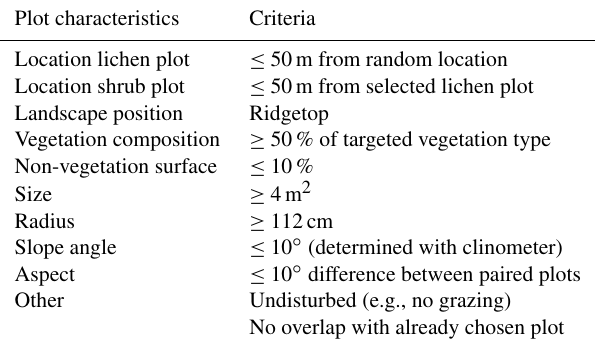
Table 1. Criteria for the selection of lichen and corresponding shrub-dominated plots. Table adapted from Aartsma et al. (2020). Plot